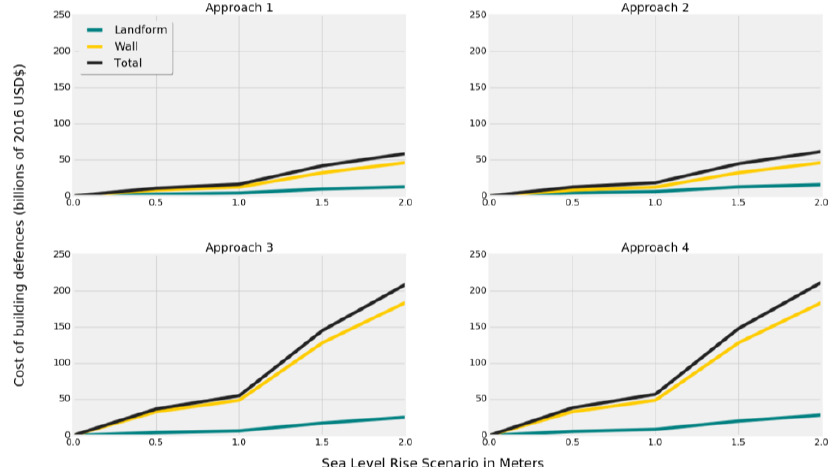
Figure 7. Figure comparing the four different cost calculation approaches for Shoreline B in billions of 2016 USD$. The two approaches on the left side (#1 and #3) do not include land purchase costs for the landform cost calculation, whereas the two approaches on the right side (#2 and #4) include a land purchase cost. The upper two approaches (#1 and #2) use a linear calculation for landforms and wall cost calculation, whereas the two approaches on the bottom (#3 and #4) have a more nuanced approach to levee and wall cost calculations. Each subplot shows landform, wall, and total costs in billions of dollars starting at no sea level rise and extending to 2.0 m of sea level rise.